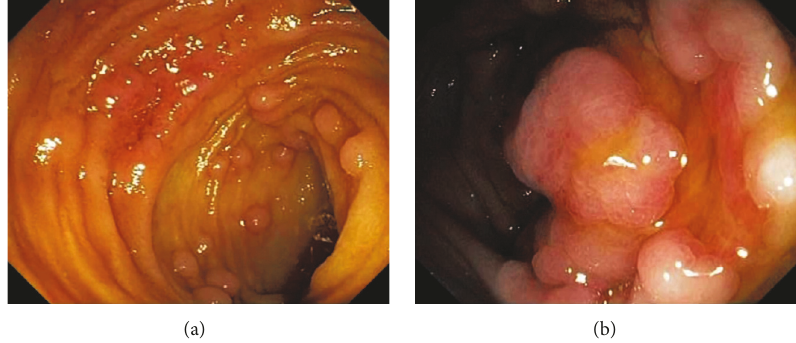
Figure 26: Endoscopic image of ileocecal histoplasmosis: terminal ileum (a) and cecum (b).